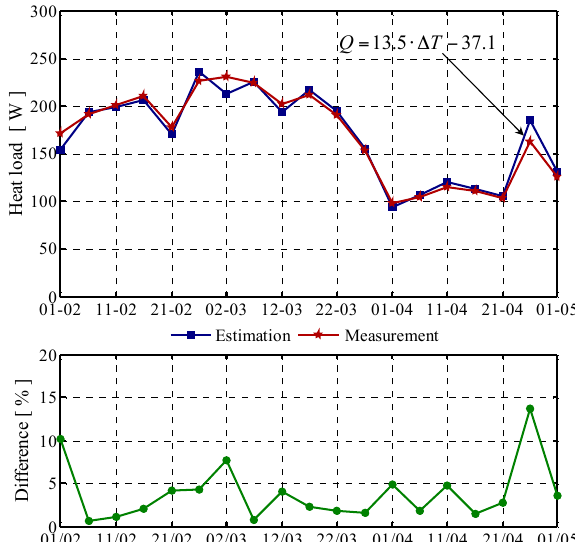
Figure 10. The experimental and the estimated heat load according to the simplified model.